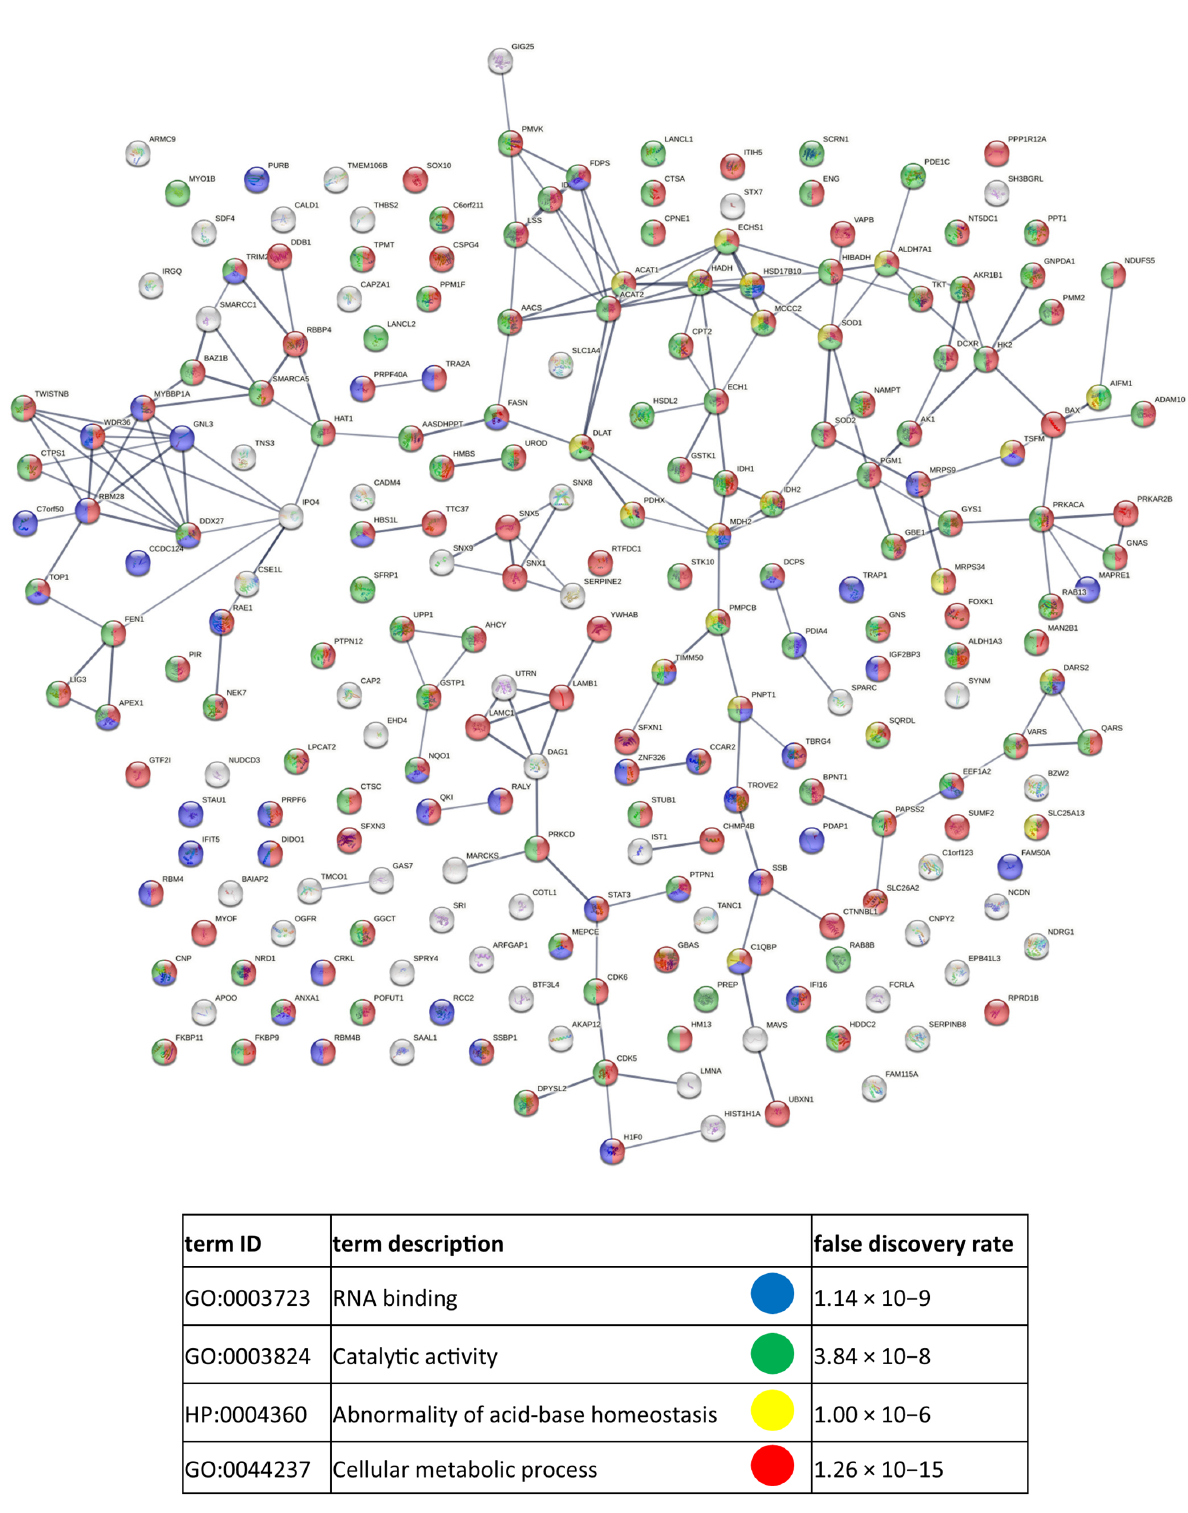
Figure A8. Diagram of functional protein association networks prepared with the use of STRING v. 11.0 software for proteins upregulated in WM793 cells vs. WM1205Lu cells. The selected, strongly rep- resented pathways are presented as an interactome. Proteins with fold change > 1.5 were considered upregulated in WM793 cells ( p < 0.001). A complete analysis is presented in Supplementary Data